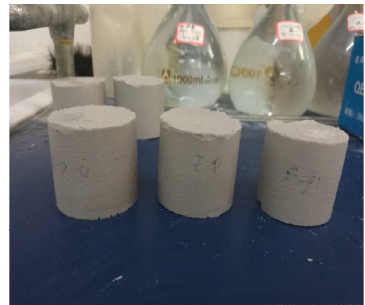
Figure 3: Hardened solidified SPT samples.